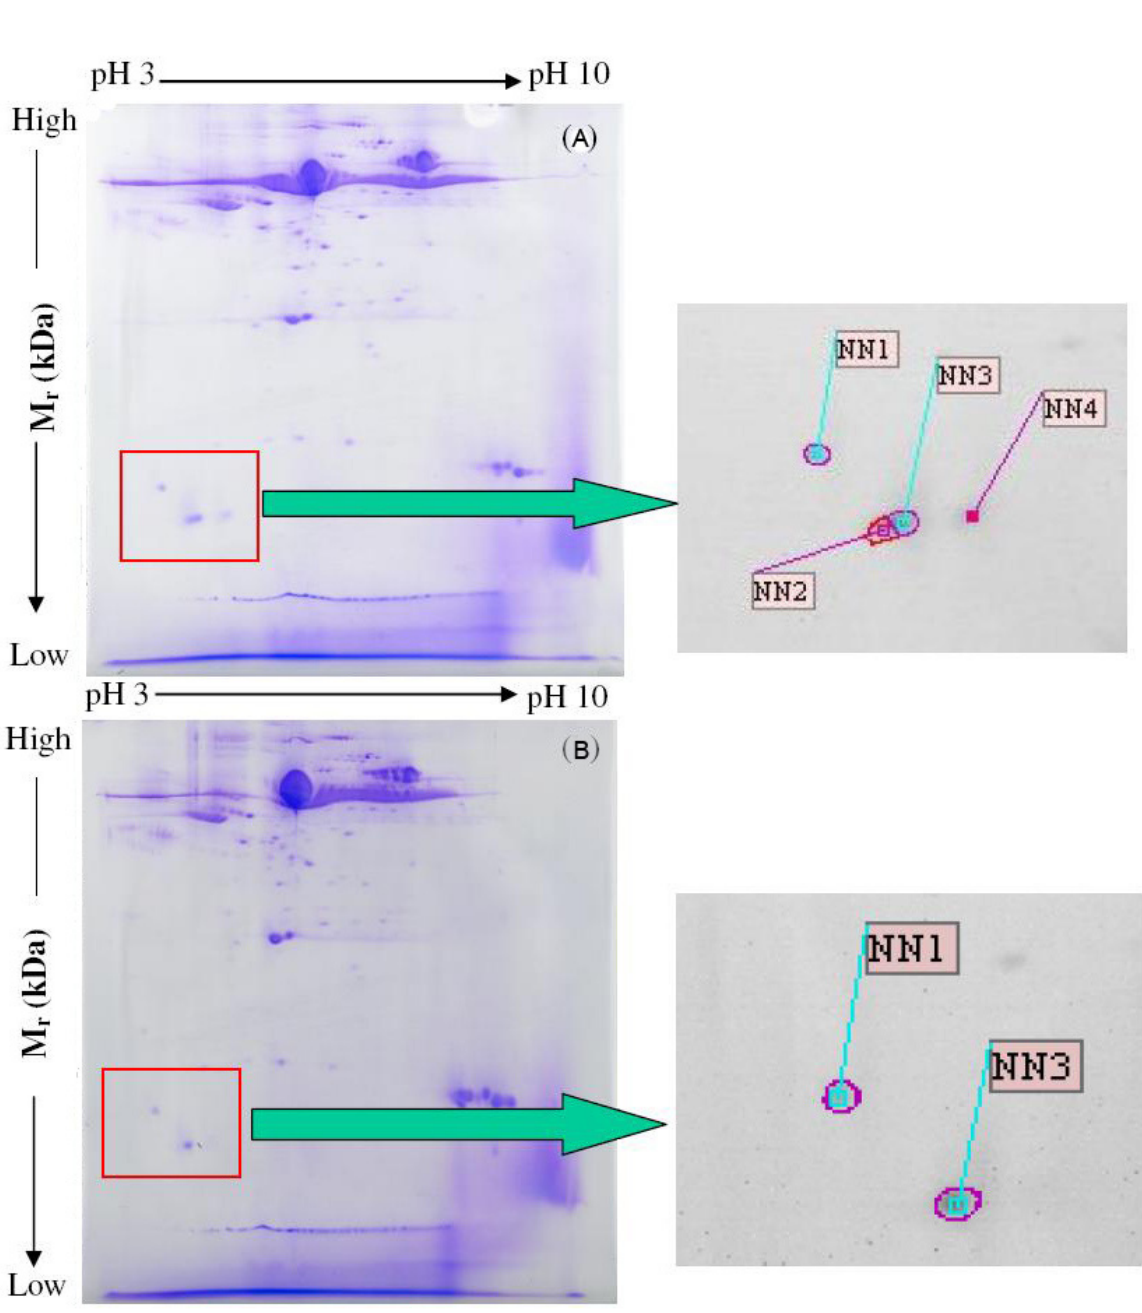
Figure 2. Expression of protein spots between mice treated with (A) snake venom and (B) M. pudica tannins plus venom. Spots designated NN2 and NN4 were missing from the 2-DE map of M. pudica tannin treated mouse